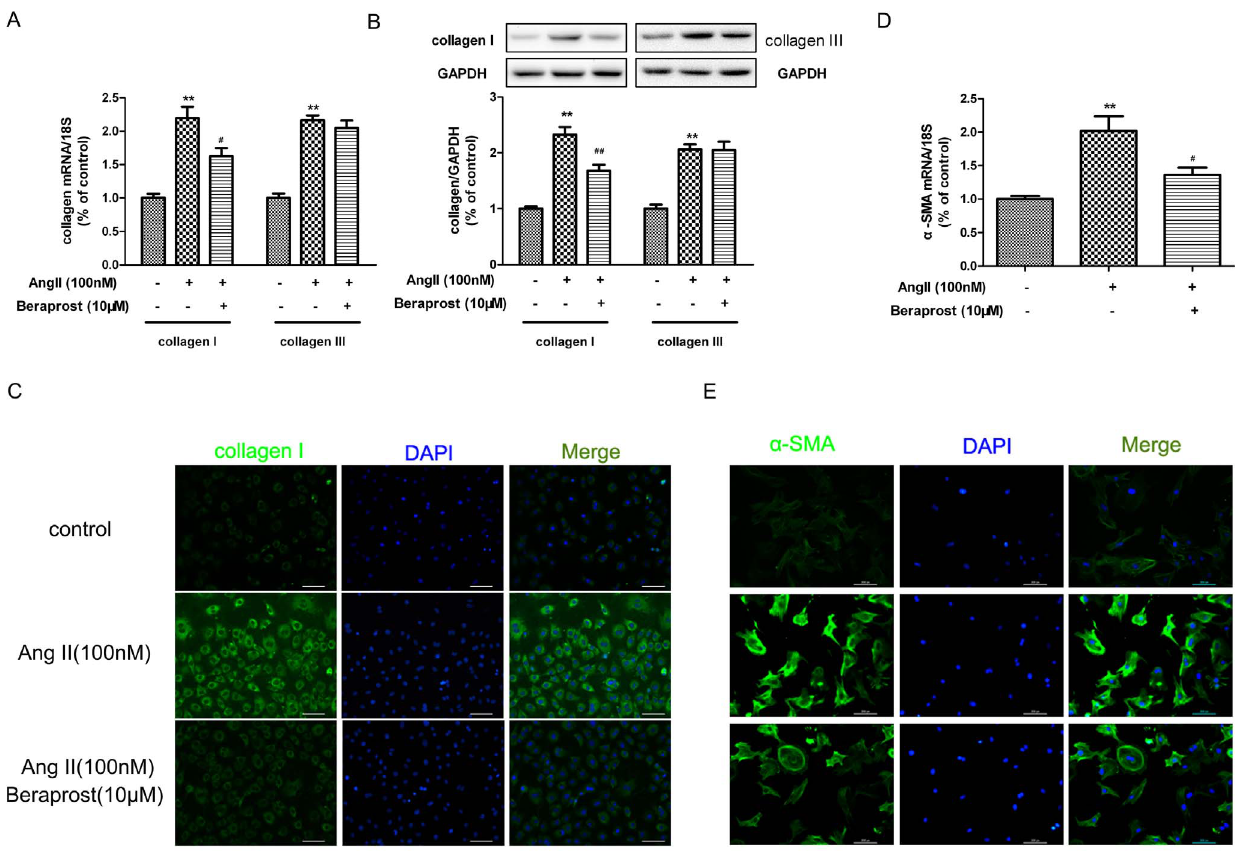
Figure 2. Effects of beraprost on Ang II-induced collagen synthesis in cardiac fibroblasts. Neonatal rat cardiac fibroblasts were pre- treated with beraprost (10 m M) for 4 h followed by Ang II (100 nM) stimulation for an additional 24 h. (A) Collagen I and collagen III mRNA expressions were assessed by real time PCR. (B) Cell lysates were tested for collagen I and collagen III protein expression by western blot. (C) Cellular collagen I was visualized using Alexa Fluor 488 conjugated IgG by immunofluorescence staining. The nuclei were counter-stained with DAPI (Scale bar: 100 m m). (D) Expression of a -SMA mRNA was assessed by real time PCR. (E) Cellular a -SMA was visualized using Alexa Fluor 488 conjugated IgG by immunofluorescence staining. The nuclei were counter-stained with DAPI (Scale bar: 100 m m). Values are expressed as mean 6 SEM. Cells treated with culture medium served as a vehicle control (con). ** P , 0.01, compared with con, # P , 0.05, ## P , 0.01 compared with only Ang II stimulated group.